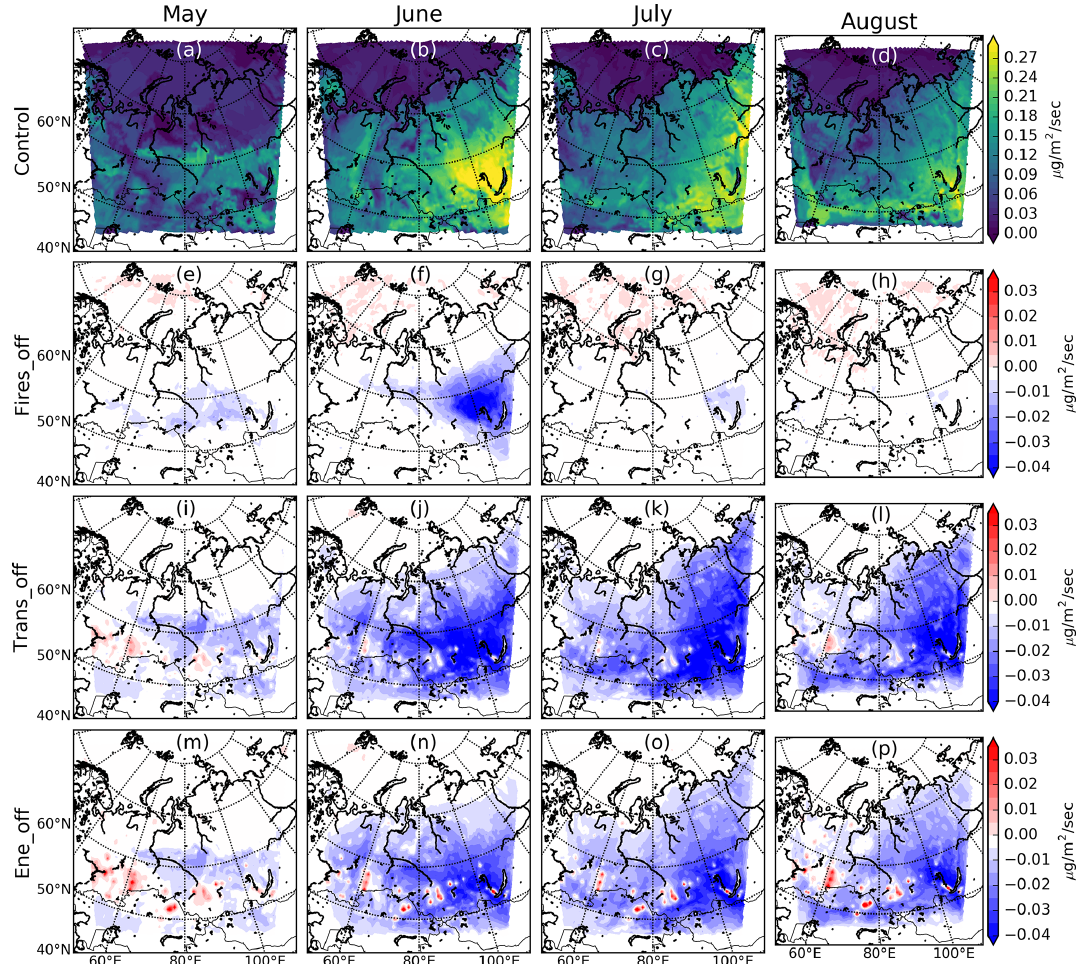
Figure 10. As Fig. 7 but for model-simulated ozone dry deposition